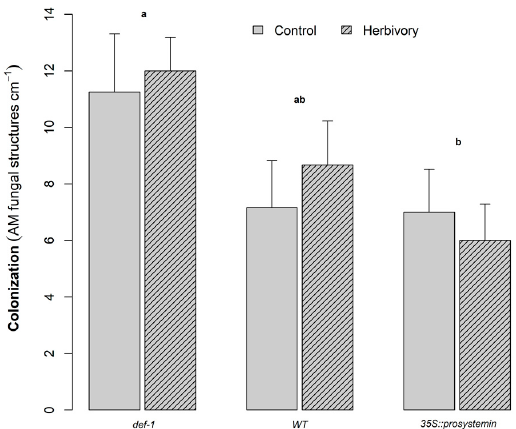
Figure 2. AM root colonization (mean + SE, n = 6) depending on herbivory treatment and plant type: JA expression deficient plants (def-1), wild-type plants (WT), and prosystemin constitutive expression plants (35S::prosystemin). Root colonization was measured after eight weeks of growth. Letters above the bars indicate significant difference among plant types according to Tukey’s mean separation test ( p < 0.05).